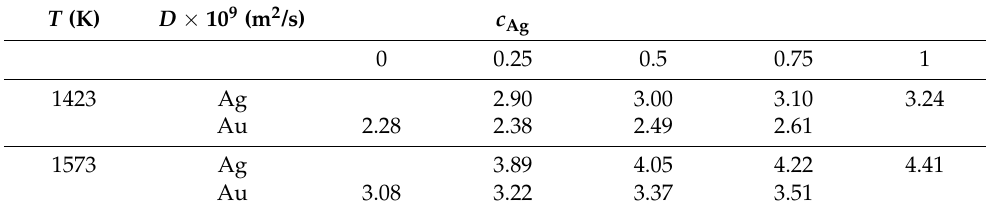
Table 3. Self-diffusion coefficients of Ag and Au in liquid Ag-Au alloy at T = 1423 K and T = 1573 K. T (K) D × 10 9 (m 2 /s)